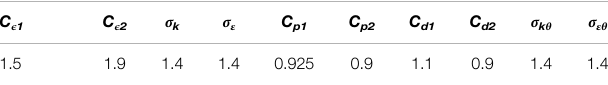
TABLE 1 | Values for the k − ~ ε − k θ − (cid:1) ε θ model constants in Eqs 9 – 12